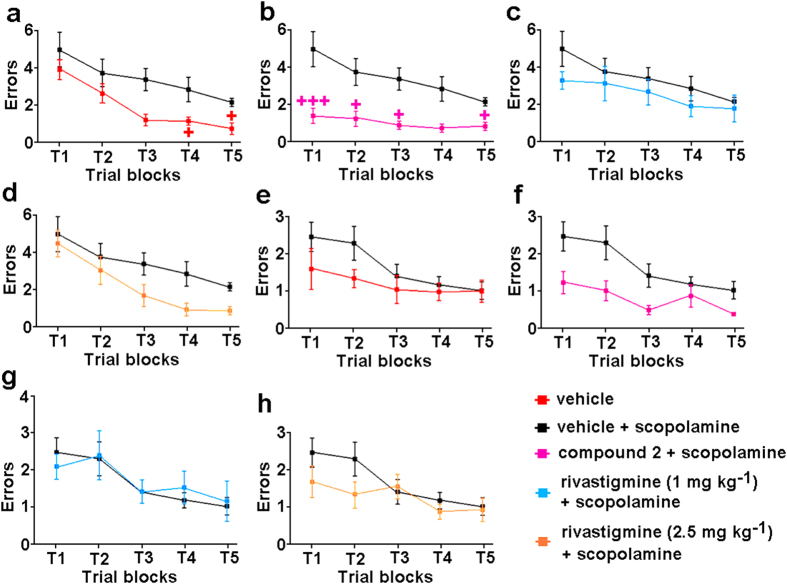
Effects of compound 2 and rivastigmine on scopolamine-induced memory impairment in the two-day radial arm water maze task.Spatial learning deficits expressed as mean number of errors ± SEM in 15 trials in five blocks (T1–T5) of three trials on day 1 (a–d) and day 2 (e–h) of the RAWM task. Vehicle-treated mice and scopolamine-treated control mice (a,f), scopolamine-treated control mice and scopolamine-induced memory-impaired mice treated with 30 mg kg−1 compound 2 (b,f), or 1 mg kg−1 (c,g) or 2.5 mg kg−1 (d,h) rivastigmine. Significance versus scopolamine-treated control mice: +p < 0.05; +++p < 0.001.